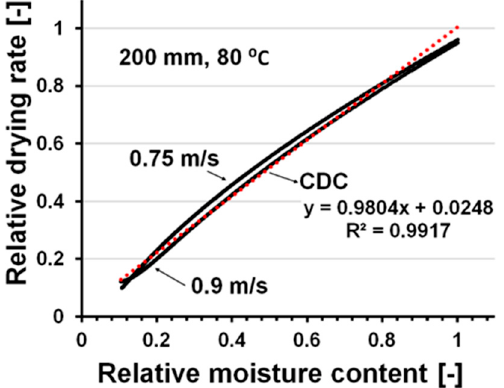
Figure 5. Characteristic drying curve for the air velocities of 0.75 and 0.9 m / s. Bed height 200 mm and air temperature 80 °C in both cases. Mixture ratio 50% soot :50% sawdust .